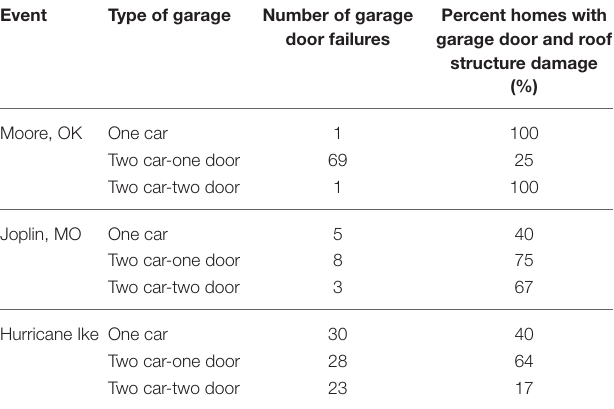
TABLE 7 | Roof structure damage in failed garage doors by type (90–109